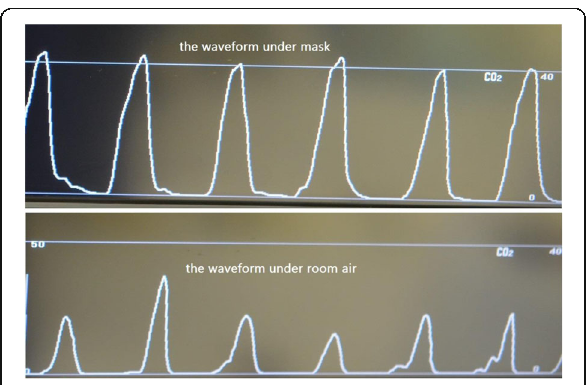
Fig. 2 The waveform under the mask and the waveform